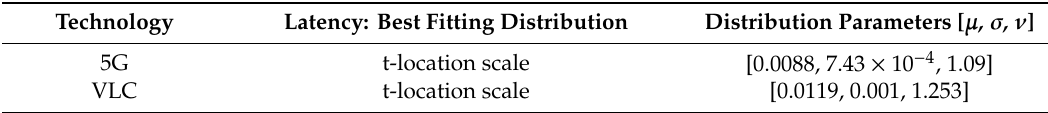
Table 2. Best fitting distribution for 5G and VLC technologies.